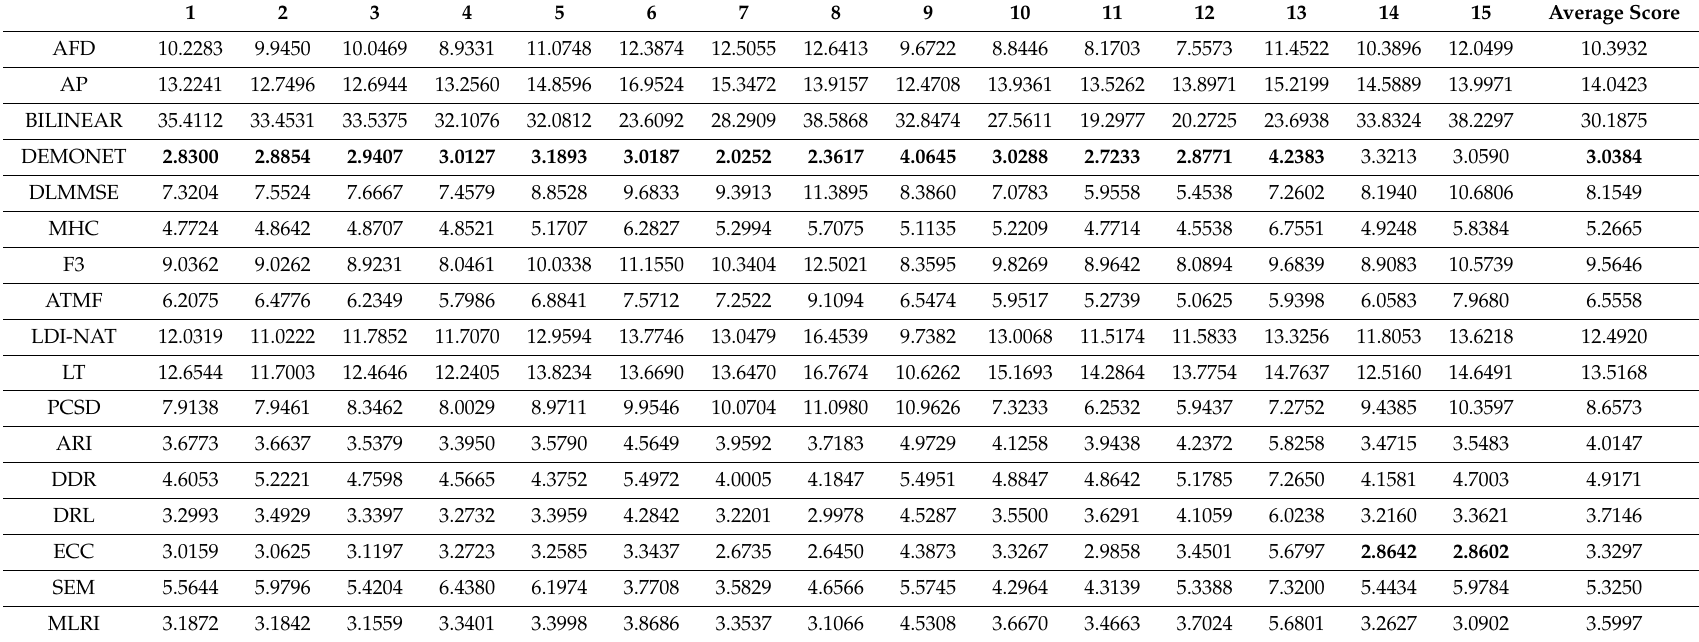
Table 6. Summary of NIQE scores (lower = better). Fifteen right images: Green